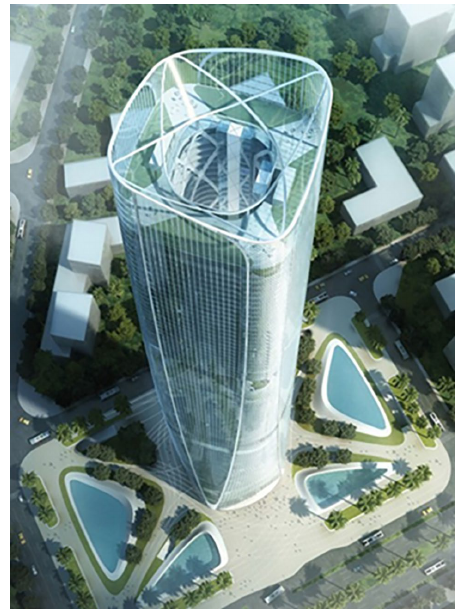
Figure 1. “Haikou Tower” architectural